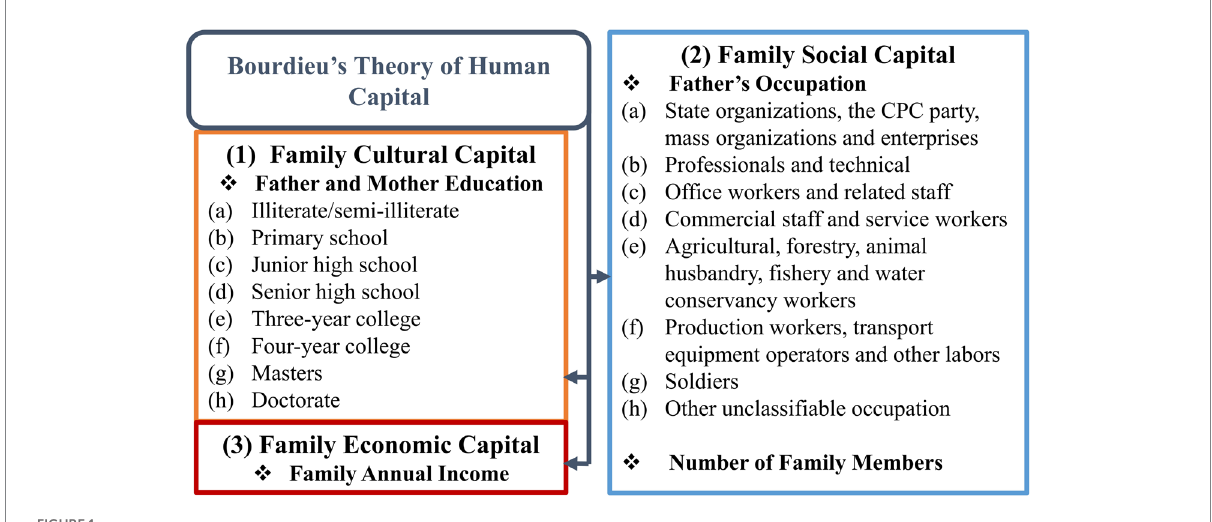
FIGURE 1 Based on Bourdieu’s theory of capital, indicators of data